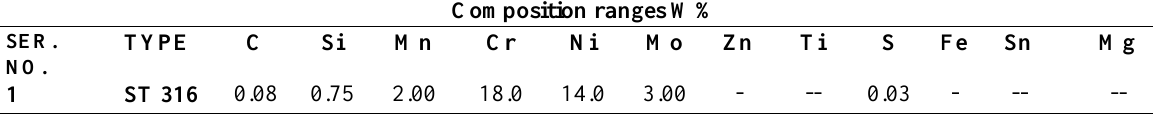
Table 3, Chemical composition of stainless steel type 316 plate [11 ]